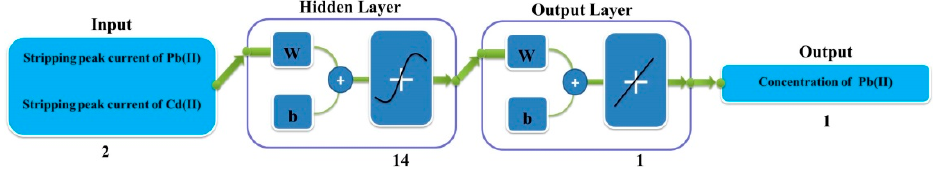
Figure 1. Schematic of an ANN structure to predict the concentration of Pb(II).